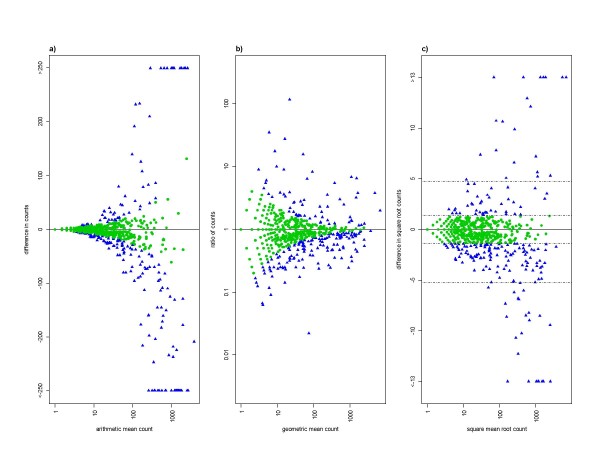
Variation between readers in asexual parasites counts from cross-sectional surveys of malaria in northeastern Tanzania[29]. The vertical axes show between-reader differences in terms of a) absolute difference in counts, b) ratio of counts and c) difference in square root counts. Different types of mean are used on the horizontal axes to ensure that the two axes are uncorrelated: arithmetic mean, geometric mean, and square mean root, respectively. Pairs with a zero reading (n = 702, or 45% of 1564) are not included in panel b) because they give rise to infinite ratios. To increase comparability, they also are omitted from the other two panels. Hence each panel shows 862 paired readings. In panel a), differences in either direction of more than 250 parasites (42 pairs, or 5% of 862) are plotted together at the ends of the vertical axis. This is to stop outliers dominating the figure. This is also done in panel c) for differences in square roots greater than 13 (16 pairs, or 2%). In panel c), the outer pair of horizontal lines shows the 95% range of the difference in square roots: -5.3 to 4.7. The inner pair of horizontal lines shows the range expected under the lower limit on this 95% range from the Poisson distribution: -1.39 to +1.39. In all three panels, the points are green circles or blue triangles, according to whether their difference in square roots is inside or outside this range.